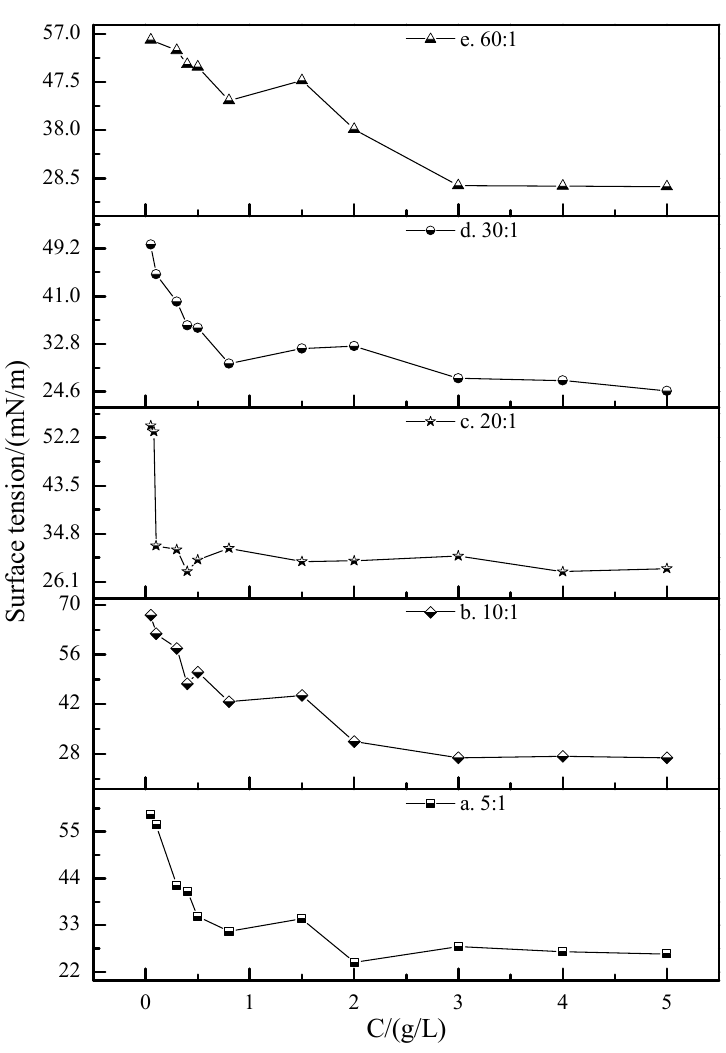
Figure 6. The surface tension of NHSi with different n ‐ OH :n ‐ epoxy.